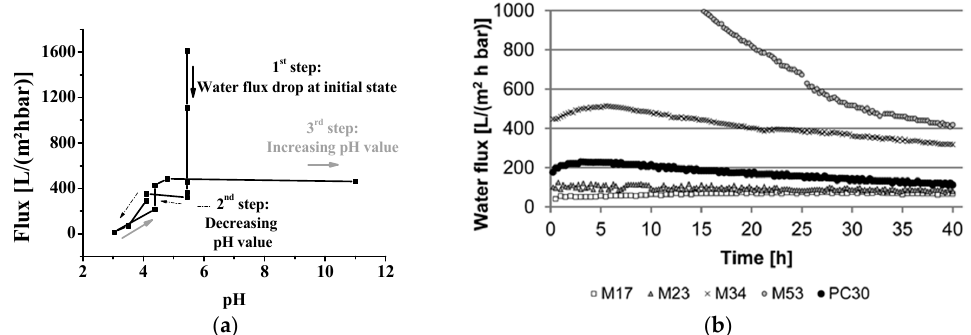
Figure 1. ( a ) pH-dependent water flux measurement of an isoporous block copolymer membrane with flux decline at initial state (water flux drop). (Reproduced from [11] with permission; Copyright 2012 Wiley-VCH Verlag GmbH & Co., KGaA). ( b ) Water flux measurements for membranes made from polystyrene- block -poly(4-vinylpyridine) with different pore sizes and with different flux decline. (Reproduced from [20] with permission; Copyright 2014 Royal Society of Chemistry).